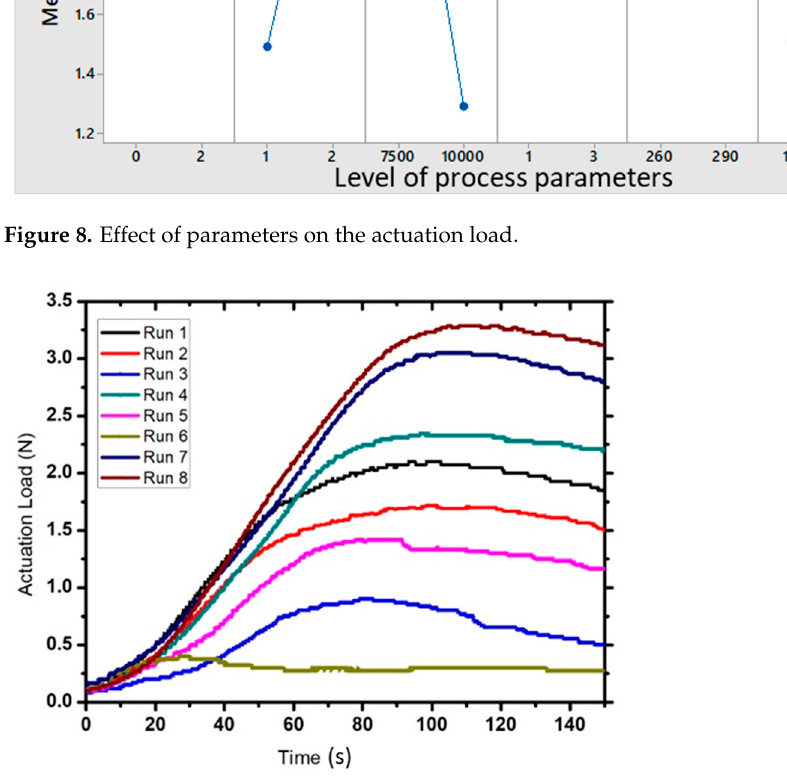
Figure 8. Effect of parameters on the actuation load.